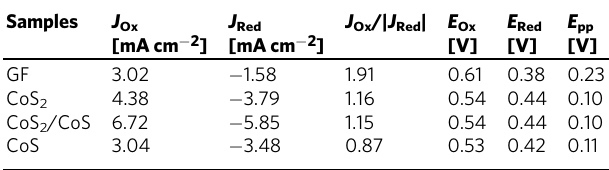
Table 2 Parameters obtained from CV curves for I − /I 3 − on GF, CoS 2 , CoS 2 /CoS, and CoS, respectively